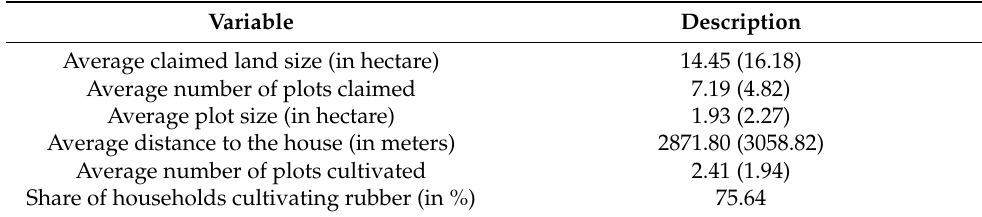
Table 6. Descriptive results: agricultural